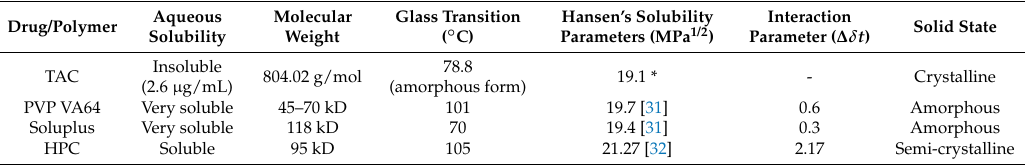
Table 1. Properties of drug and carrier polymers. TAC: Tacrolimus; PVP VA64: Polyvinylpyrrolidone vinyl acetate; HPC: Hydroxypropyl